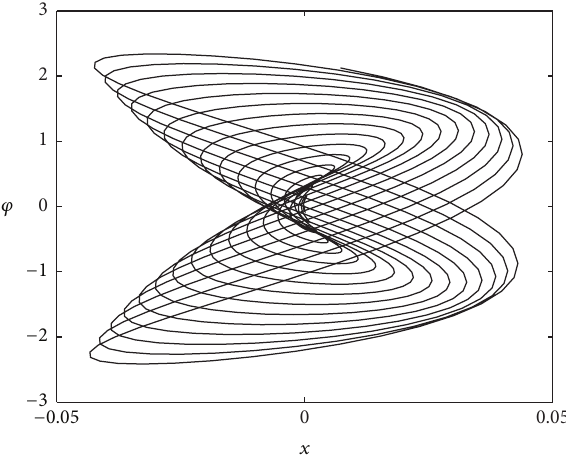
Figure 9: Diagram illustrating the variation of 𝑥 via 𝜑 when 𝜔 2 =